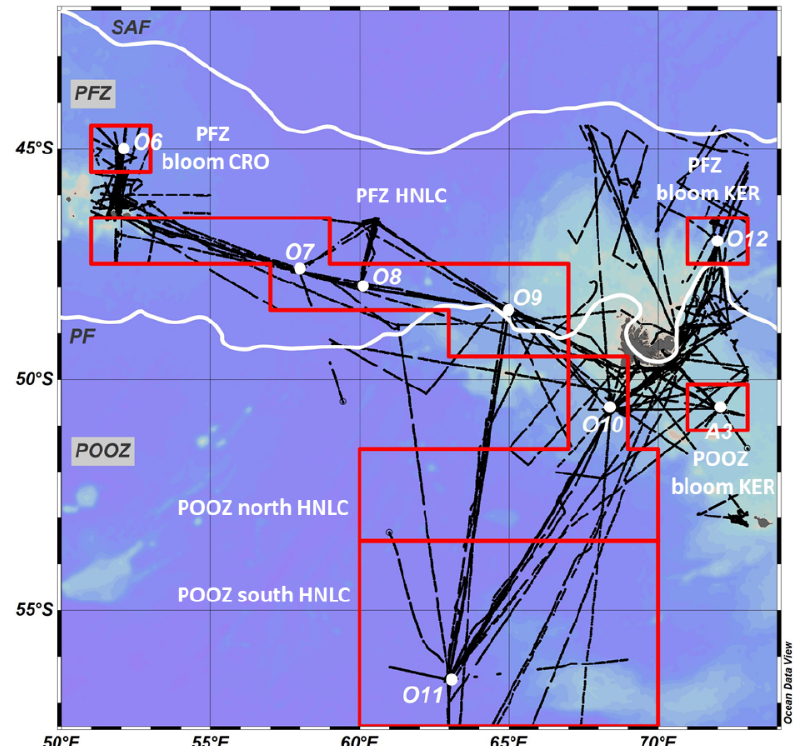
Figure 2. Tracks of summer cruises in 1998–2019 with sea surface fCO 2 data (black dots) from SOCAT version v2020 (Bakker et al., 2020). The six areas identified in Tables 2–4 are represented with red square boxes. SAF and PF are indicated in white as in Fig. 1. PFZ stands for polar front zone and POOZ for permanent open-ocean zone (i.e. north of the winter ice edge). Bathymetry is plotted as background based on GEBCO-2019 (figure produced with ODV; Schlitzer,